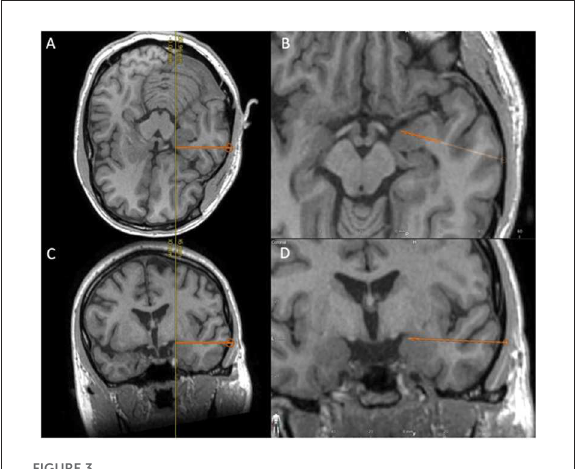
FIGURE3 Using T1-weighted MRI, we demonstrate the proposed placement of a temporal electrode that would end in the temporal piriform cortex; (A) Peri-axial in-line view, (B) enlarged peri-axial view, (C) Peri-coronal in-line view, and (D) enlarged peri-coronal